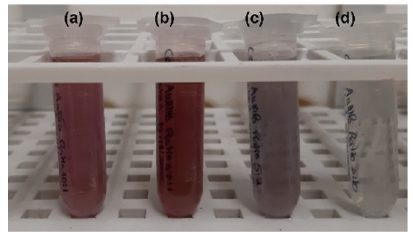
Figure 2. Macroscopic aspect of different suspensions of AuNPs. ( a ) Ratio 1; ( b ) Ratio 2; ( c ) Ratio 3; ( d ) Ratio 4.